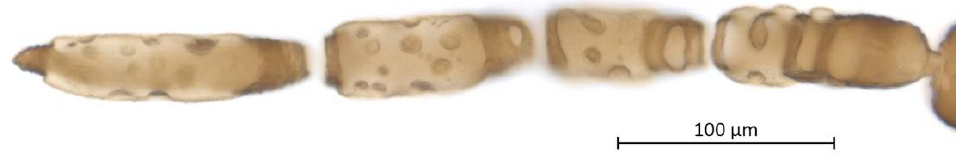
Figure 5. Antenna (ANT III-VI) and sensoria of Qiao jinshaensis sp. nov. (QMOR66201).